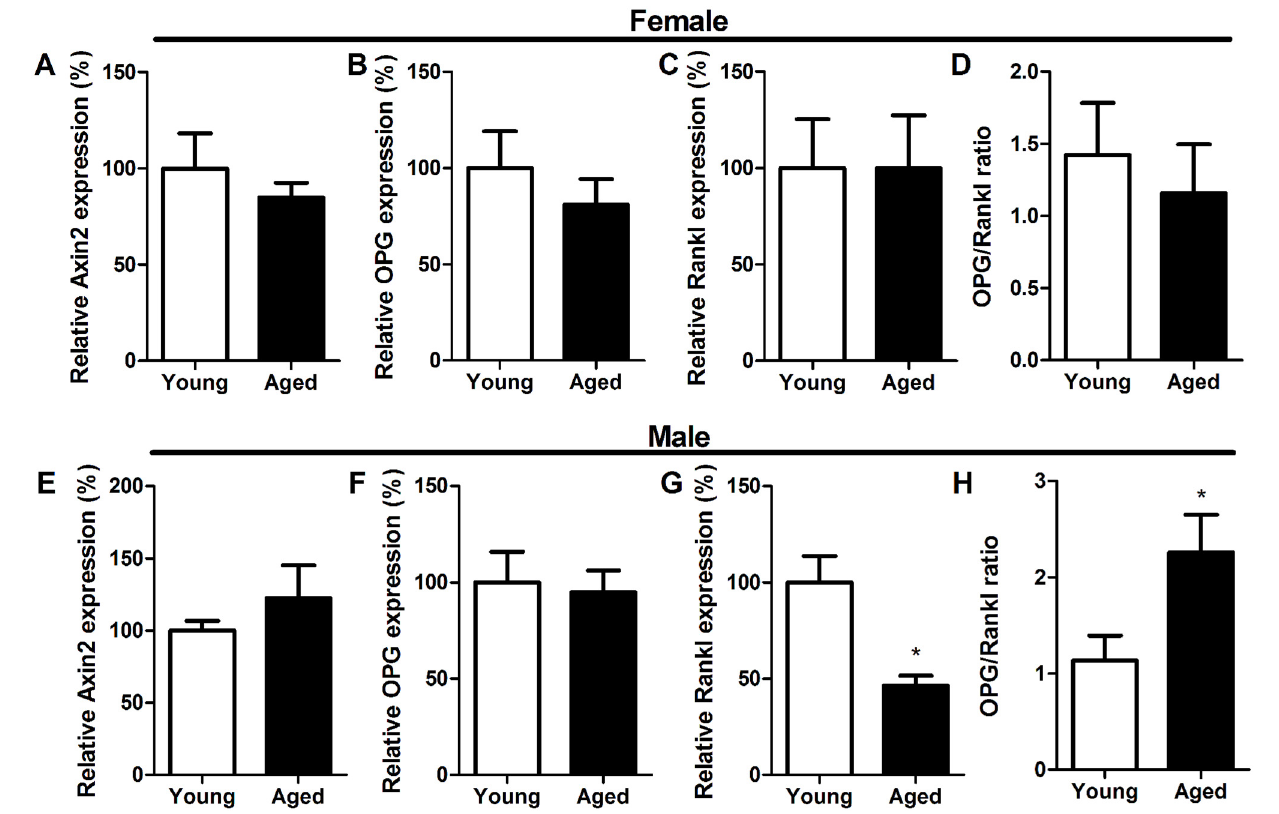
Fig 2. Ageing does not significantly alter expression of Axin2, OPG, or Rankl, in female mice but cortical bone Rankl expression is lower in aged than young male mice. (A,E) Axin2, (B,F) OPG, (C,G) Rankl and (D,H) the OPG:Rankl ratio were quantified in cortical bone from young and aged (A-D) female and (F-H) male mice by quantitative RT-PCR and normalized relative to β 2-microglobulin. Bars represent the mean ± SEM, * = p < 0.05, N = 8.